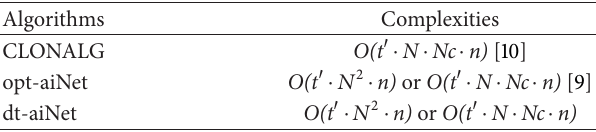
Table 1: Calculation complexities of the algorithms.